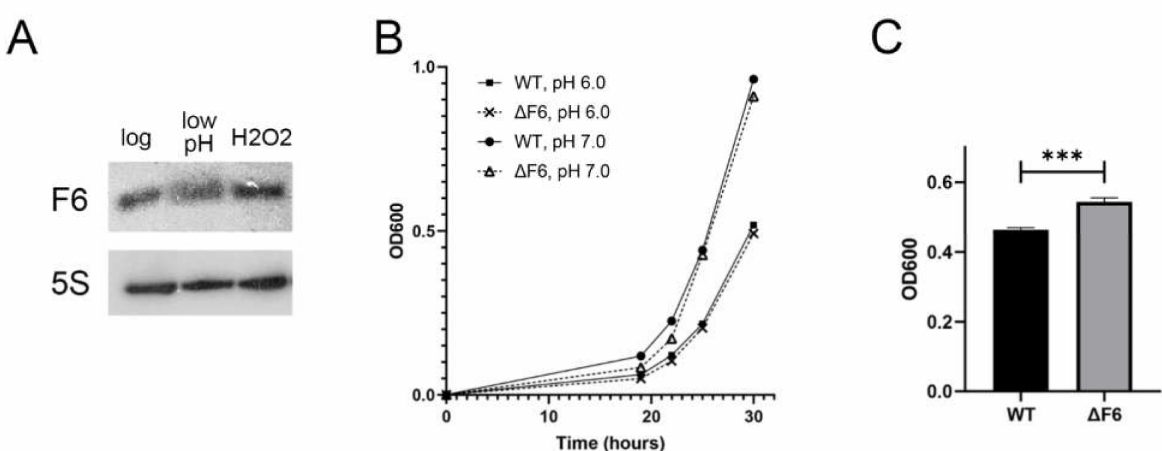
Figure 4. Effects of oxidative and acidic stresses on the M. smegmatis ∆ F6 and wt strains. ( A ) F6 transcription in the mid-log growth phase and under acidic (low pH) and oxidative (H 2 O 2 ) stresses was analyzed by Northern blotting. ( B ) Growth at neutral (pH 7) and acidic (pH 6) conditions. ( C ) Growth under oxidative stress (0.5 mM H 2 O 2 ) at eight hours after H 2 O 2 addition. The data are presented as the mean ± SD of three independent experiments; *** p <